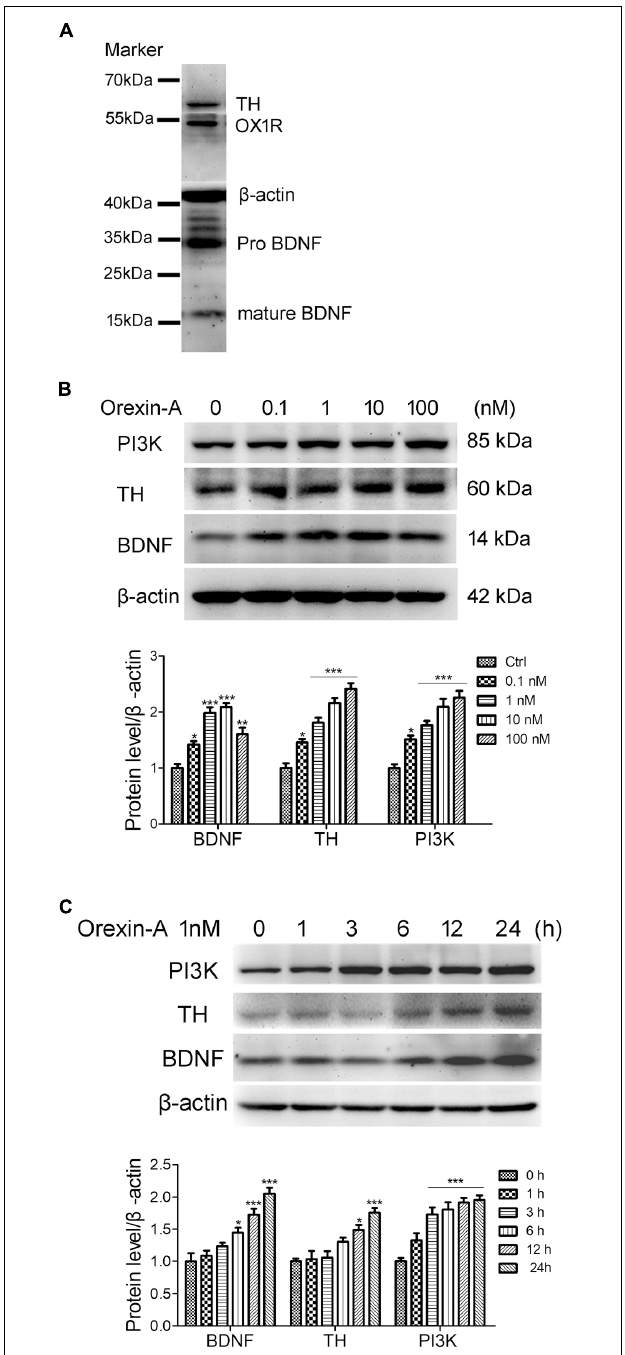
FIGURE 7 | Orexin-A increased the expression of TH and BDNF in SH-SY5Y human dopaminergic neuroblastoma cells. (A) Immunoblot analysis revealed the expression of OX1R, TH, and BDNF in SH-SY5Y cells. Original images of the blots are shown in Supplementary Figures S1 – S5 . (B) Protein expression of PI3K, TH, and BDNF in SH-SY5Y cells treated with orexin-A at various concentrations for 24 h. (C) Protein expression of PI3K, TH, and BDNF in SH-SY5Y cells treated with 1 nM orexin-A for different time periods. Average protein level was quantified as ratios between BDNF/TH/PI3K and β -actin. Data were presented as mean ± SEM of four independent experiments. ∗ P < 0.05, ∗∗ P < 0.01, ∗∗∗ P < 0.001 vs.